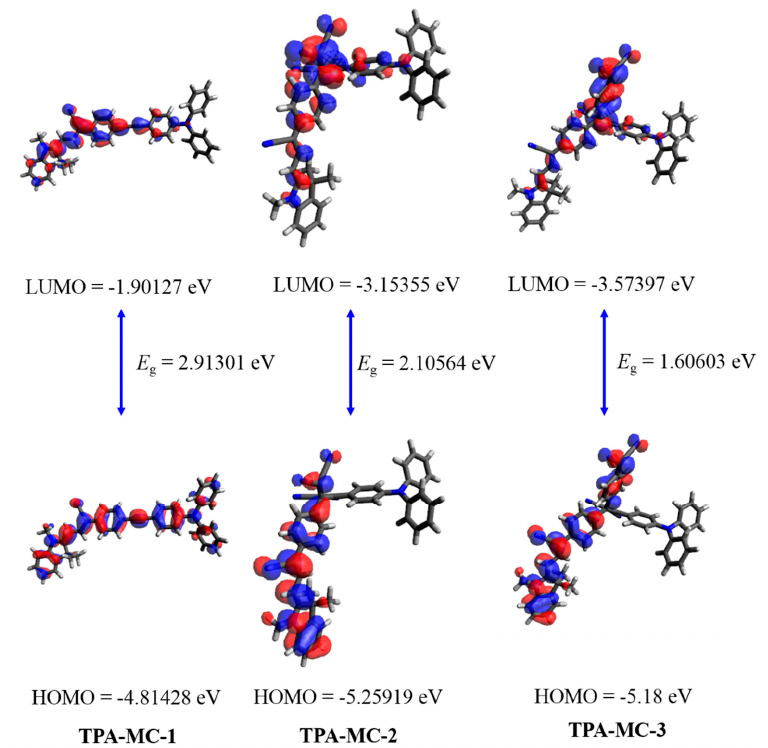
Figure 1. The molecular orbital diagrams of TPA-MC-1, TPA-MC-2, and TPA-MC-3.